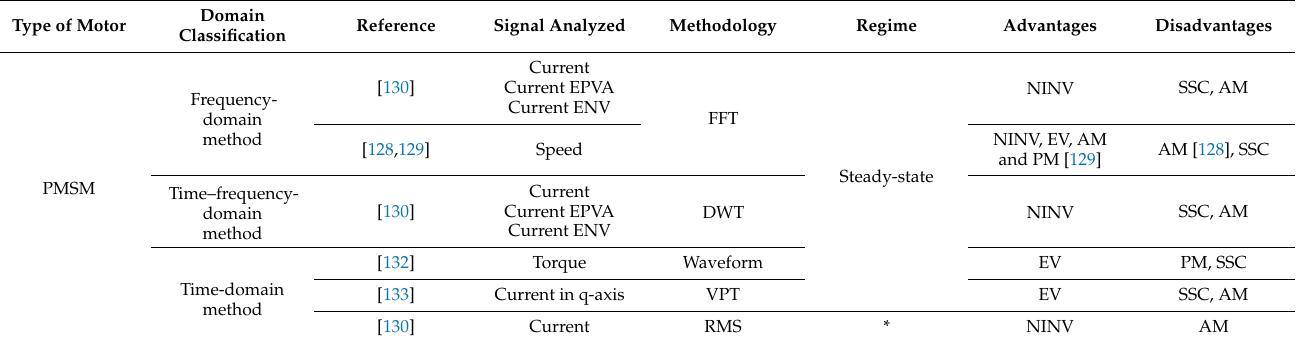
Table 6. Classification of detection methods for rotor misalignment faults in